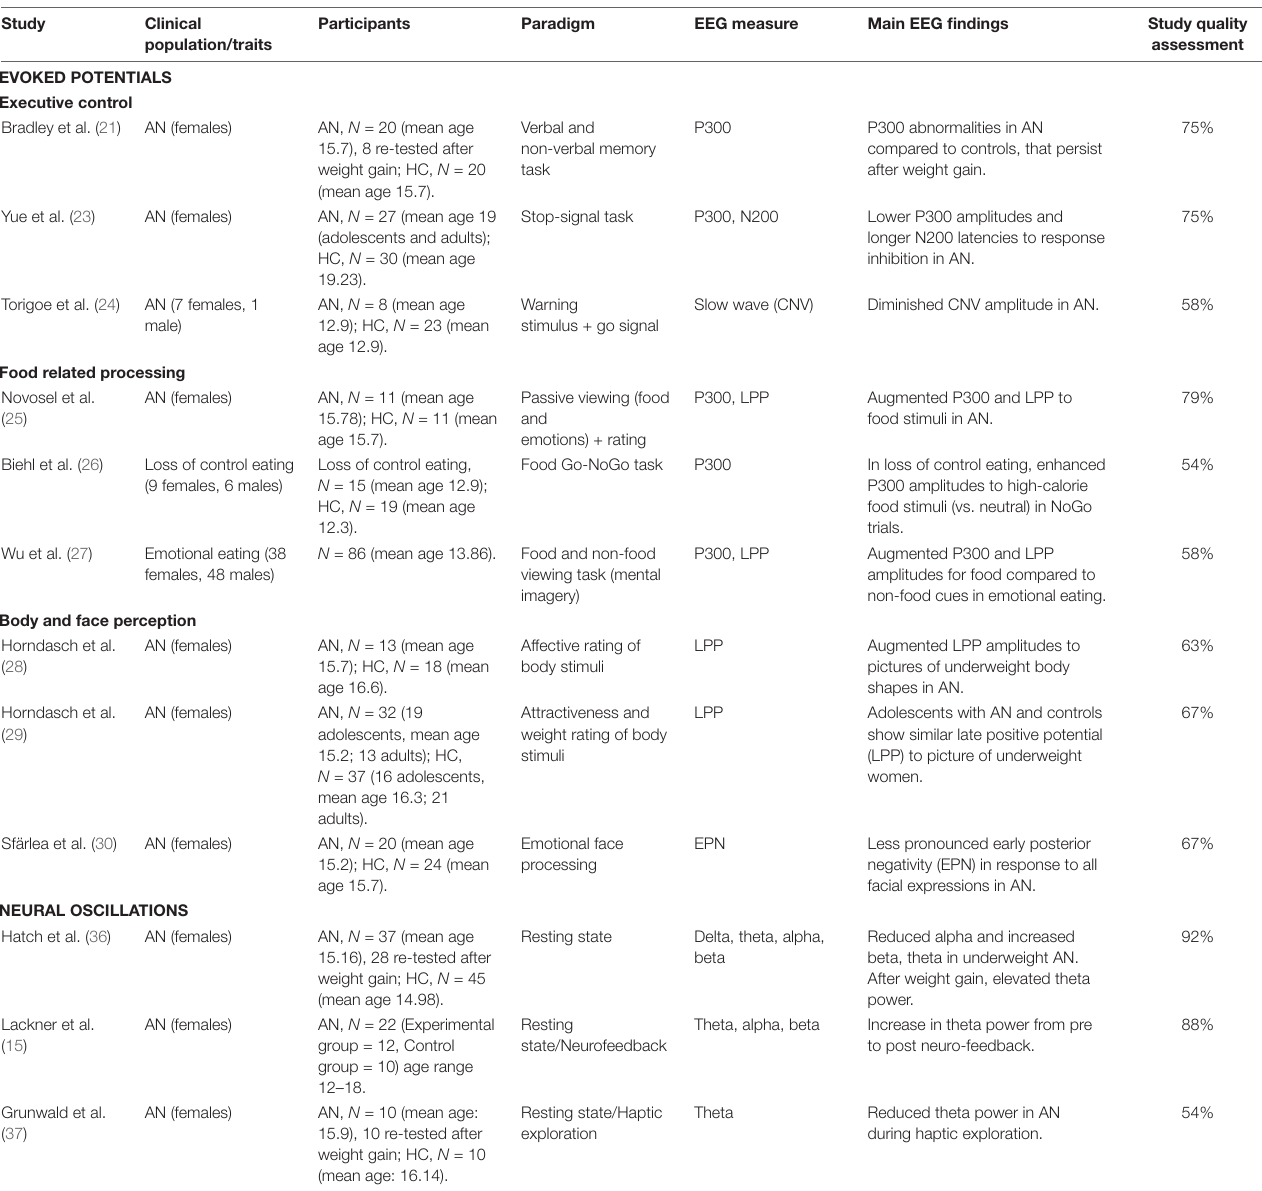
TABLE 1 | Summary of